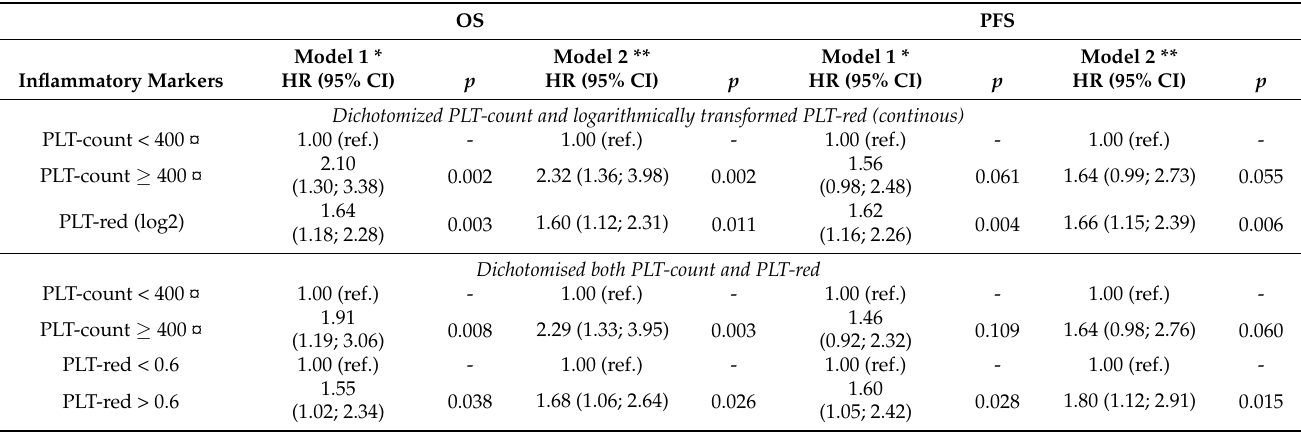
Dichotomized PLT-count and logarithmically transformed PLT-red (continous) PLT-count < 400